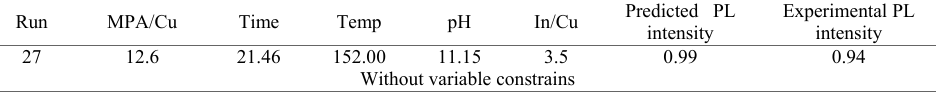
Table 4: Result of model verification at an optimum combination Table 4. Result of model verification at an optimum combination Run